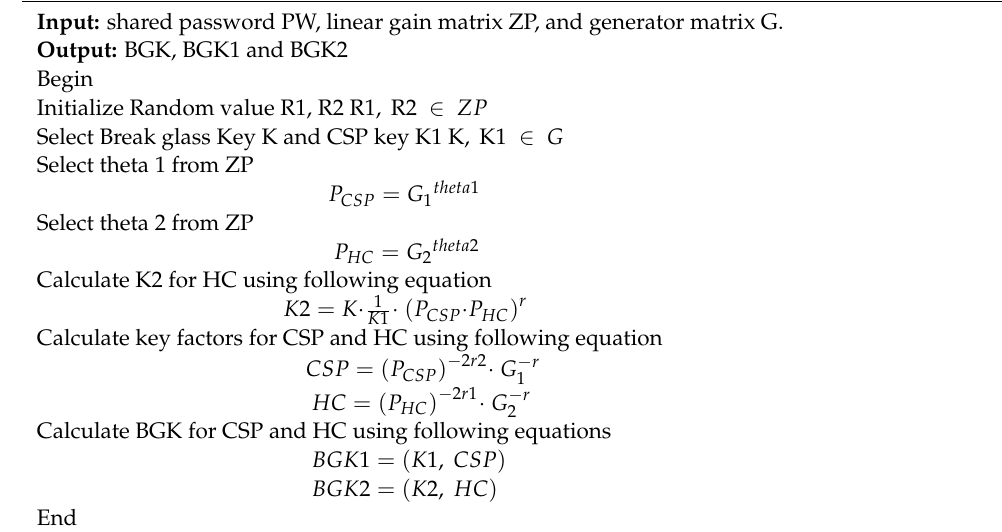
Algorithm 5: Break-Glass Key Generation